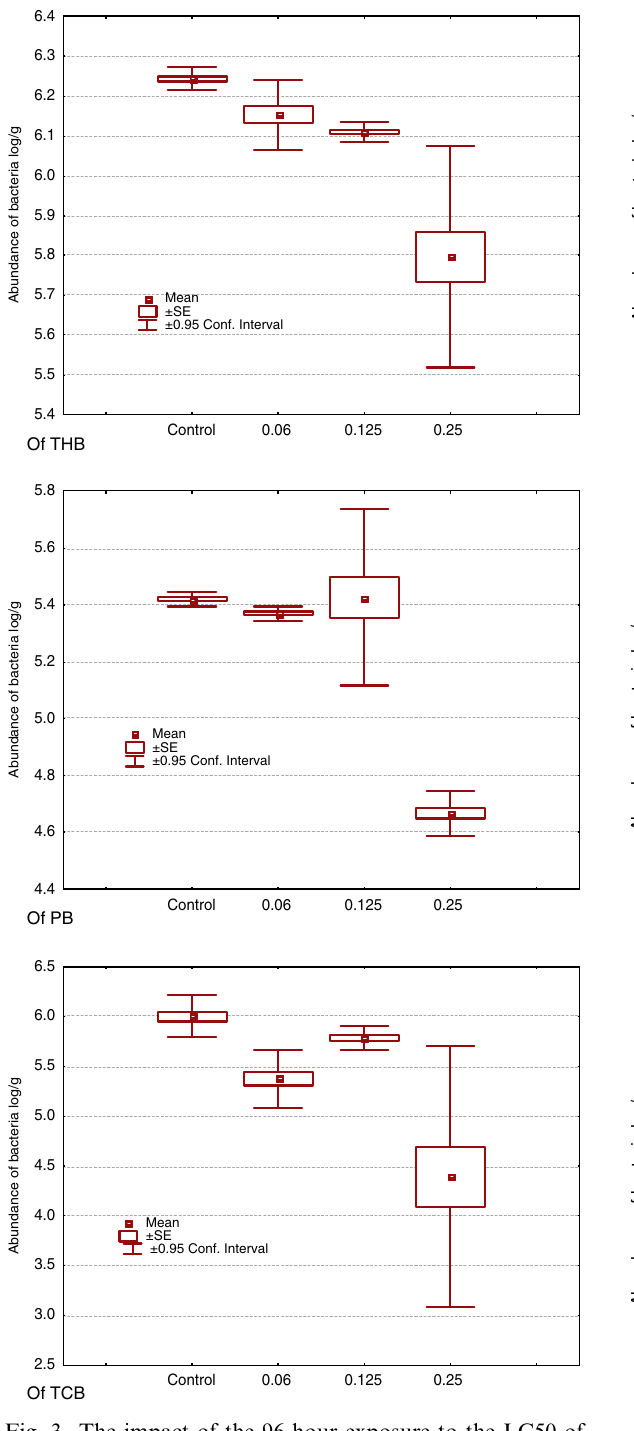
Fig. 4. The impact of the 96-hour exposure to the LC50 of Cu (cid:2) Zn ions mixture on abundance of bacteria in digestive tract of trouts after 12 days keeping fish in clean water Concentration in parts of equitoxic 96-hour LC50